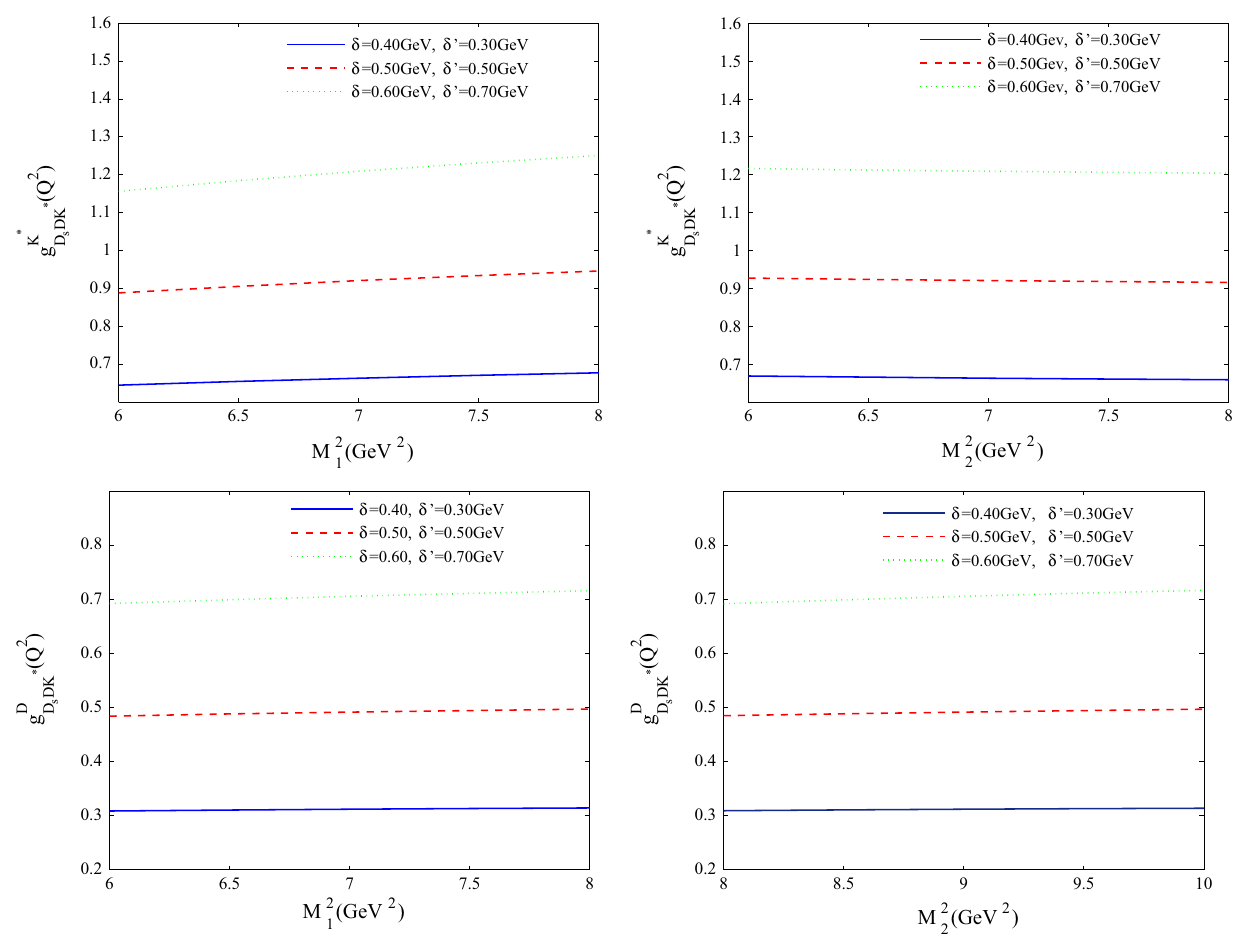
Fig. 5 M 2 and M 2 dependence of g K ∗ 1 2